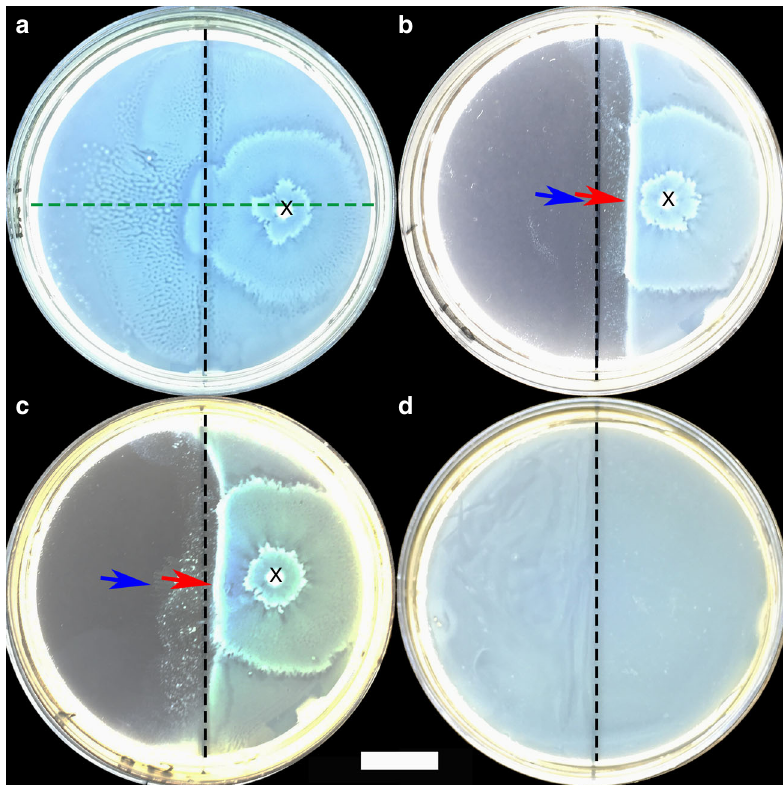
Fig. 4 Release of drug via MIMS. Colony expansion ( a – c ) and proliferation ( d ) of P. mirabilis observed 20 h after cells were inoculated on 1% ( a – c ) and 4% ( d ) agar. Copolymer 3 -coated silica particles were deposited evenly on the left side of the agar surface. 0.8 mg of drug-free particles ( a ), and 0.2 ( b , d ) and 0.05 ( c ) mg of particles containing tobramycin were used. a – c P. mirabilis cells were inoculated on the right side of agar at point x. The vertical dotted line (black) is the boundary between the particle and particle-free zones that divides the agar into two equal halves, and the horizontal dotted line (green) in a bisects it. The blue and red arrows in b and c indicate the intersection points between the horizontal bisector with the secondary and primary colony fronts, respectively. d P. mirabilis were inoculated on the whole agar and immobile P. mirabilis cells were seen to proliferate throughout the